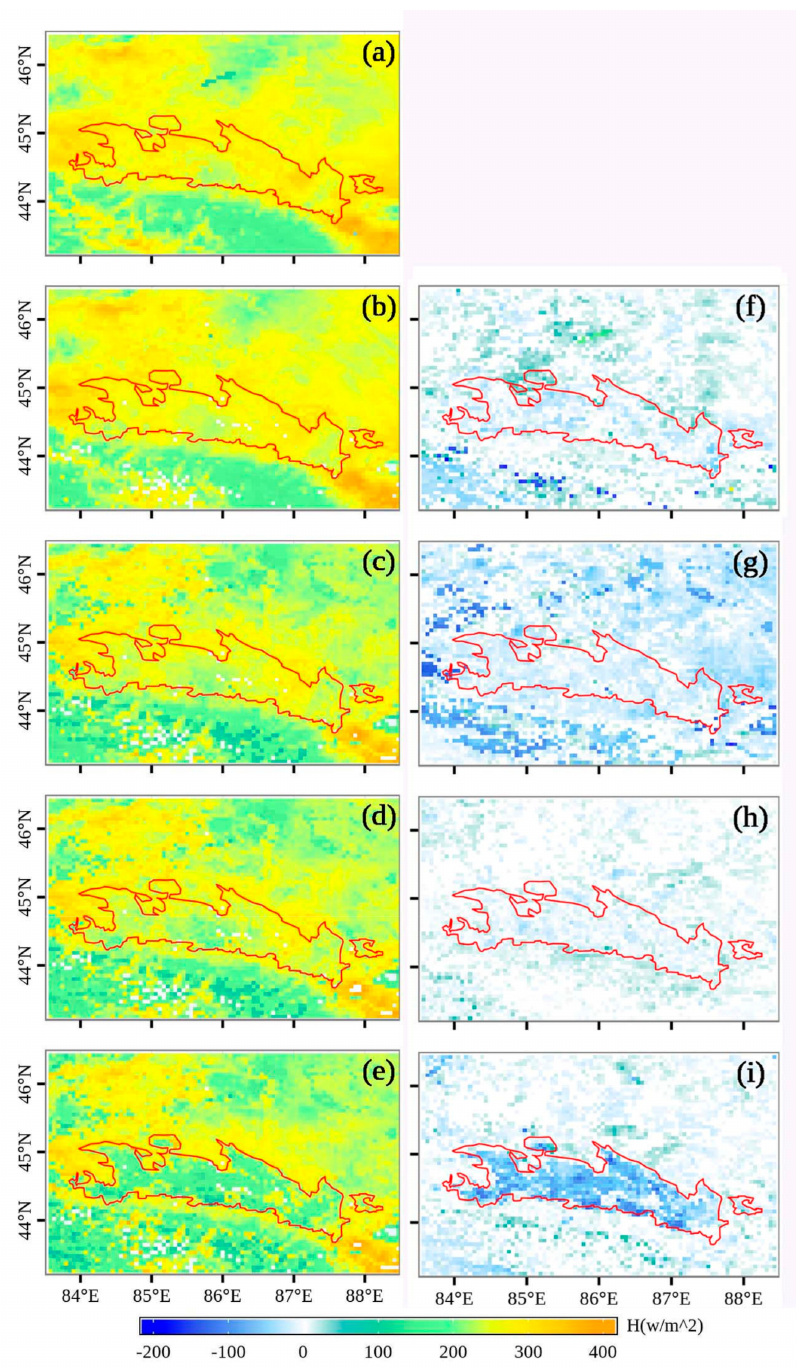
Figure 4. Daytime spatial patterns of sensible heat flux (H) from the ( a ) def, ( b ) LU, ( c ) Alb, ( d ) LAI and ( e ) VF simulations, and their differences ( f ) b – a , ( g ) c – b , ( h ) d – c and ( i ) e – d (these difference pixels are statistically significant at p < 0.05). The def simulation used default LU, albedo, LAI, and VF provided by WRF itself; the LU simulation used only actual LU data; the Alb simulation used only actual LU and albedo data; the LAI simulation used actual LU, albedo, and LAI data, and the VF simulation used all of the actual terrestrial datasets. The red line represents the border of the key oasis